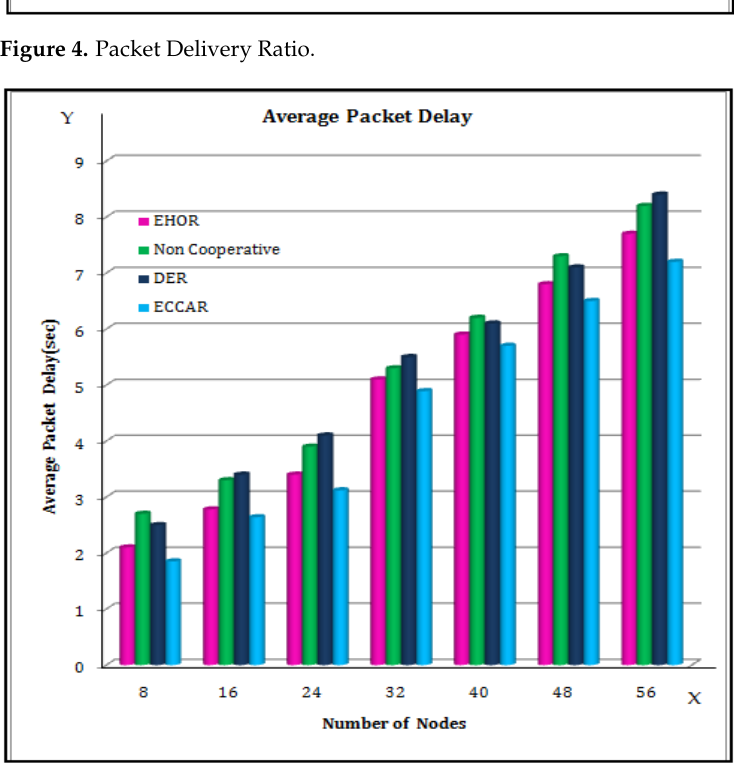
Figure 4. Packet Delivery Ratio.